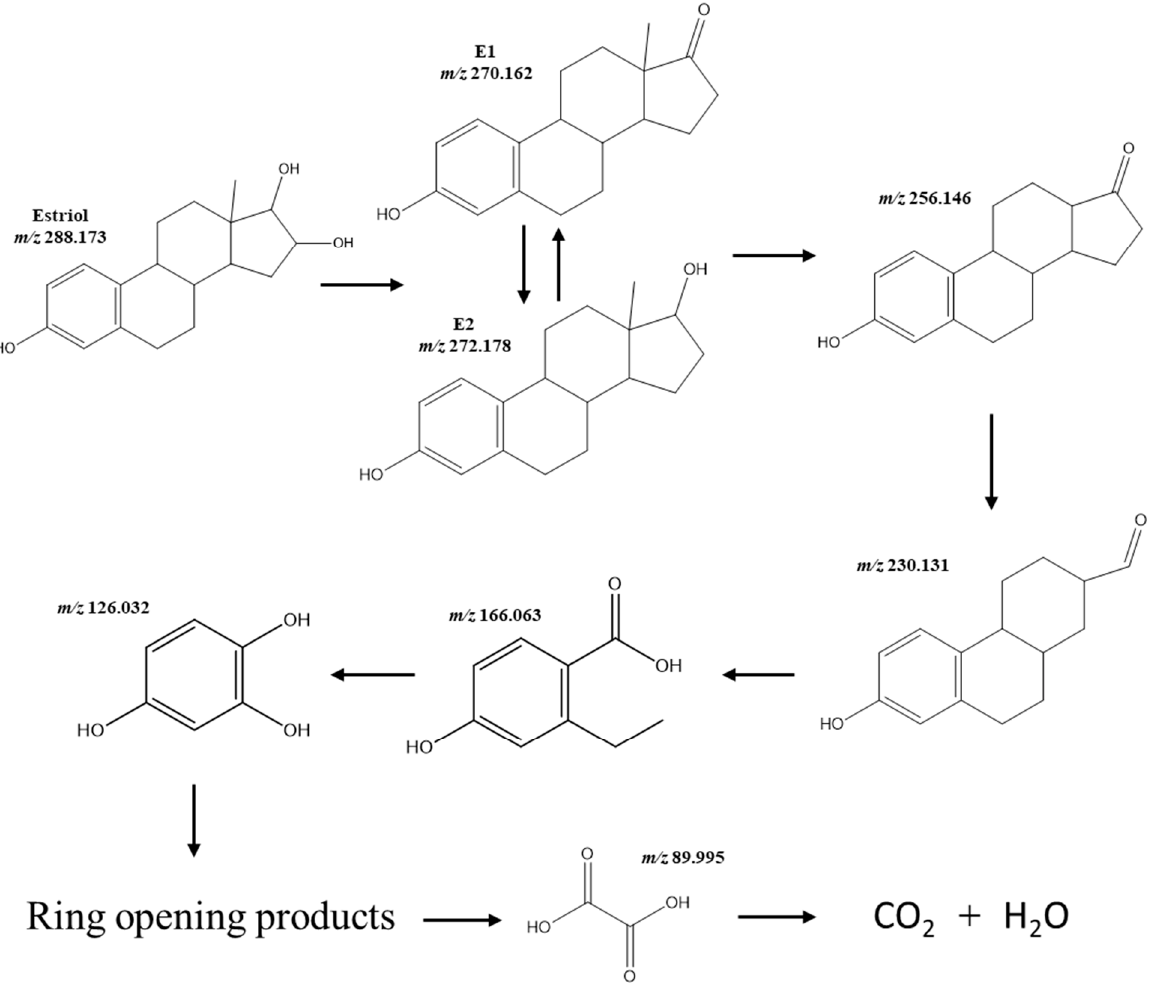
Figure 7. Proposed fragmentation pathways of E3 in the presence of B-doped TiO 2 3 wt.% catalyst under solar simulated light.